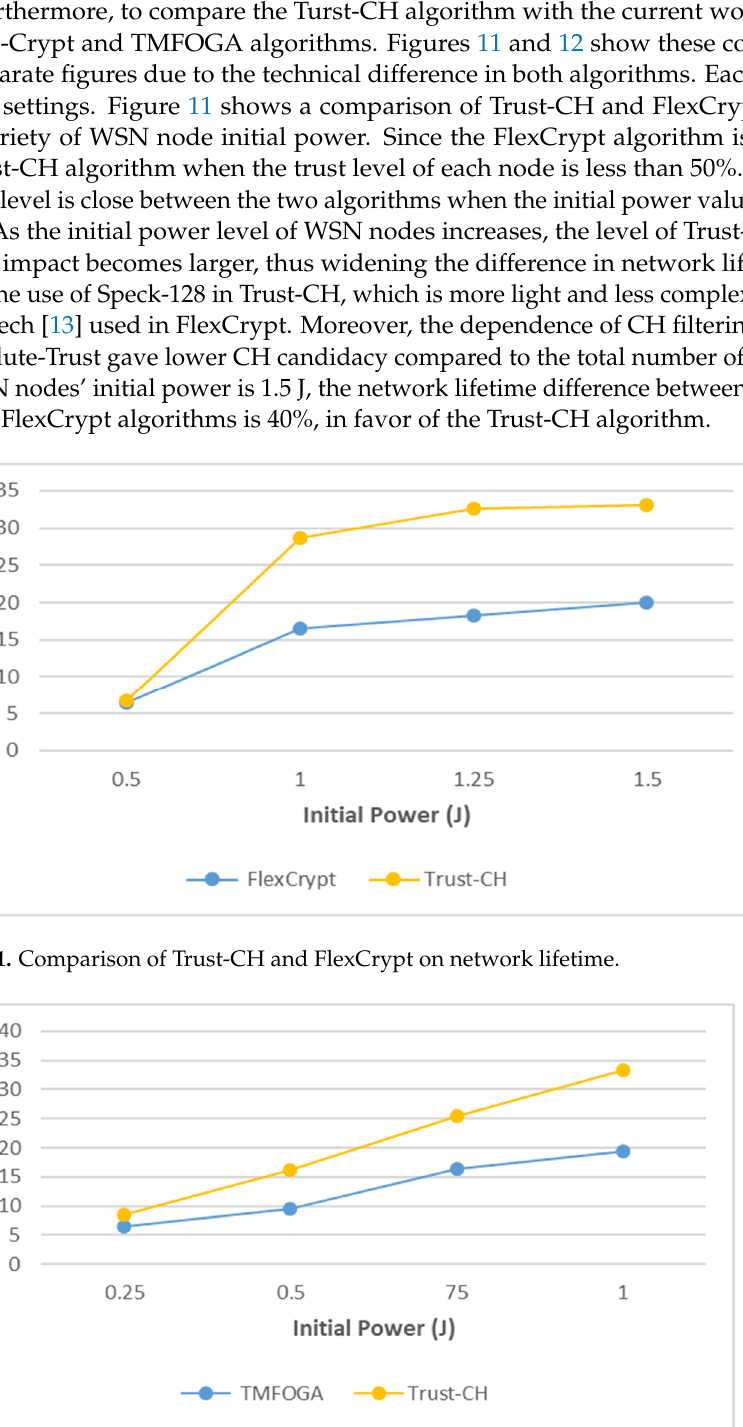
Figure 12. Comparison of Trust-CH and TMFOGA on network lifetime.